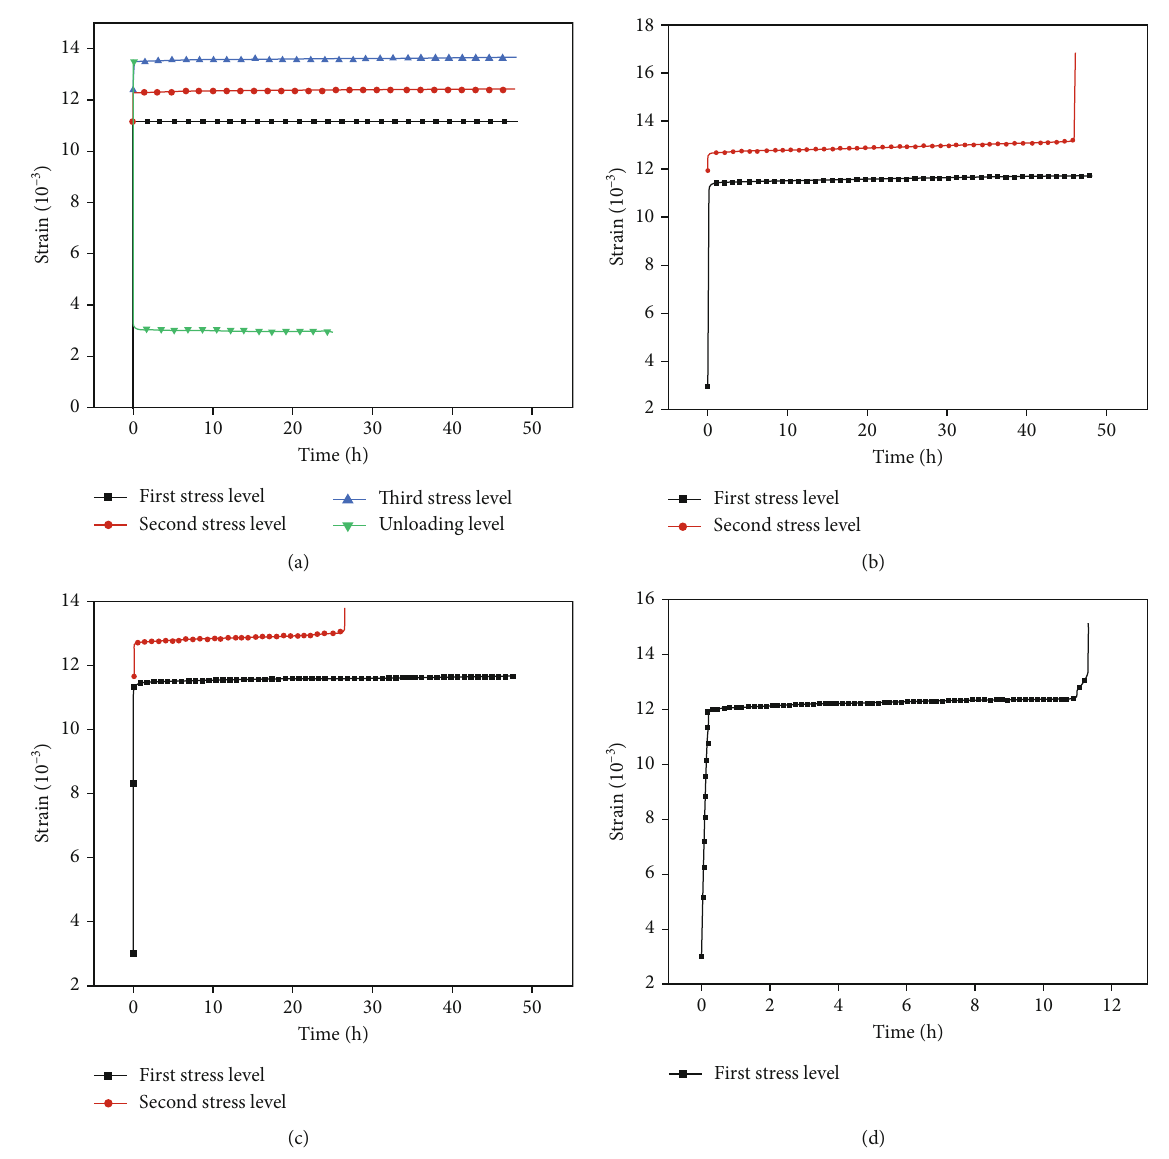
Figure 11: Creep curves at di ff erent stress levels of gypsum rock. (a) Samples in dry state during the whole loading processes. (b) Sample soaked with distilled water during the second loading process. (c) Sample under the pH = 6 acidic solution during the second loading process. (d) Sample under the pH = 5 acidic solution during the second loading